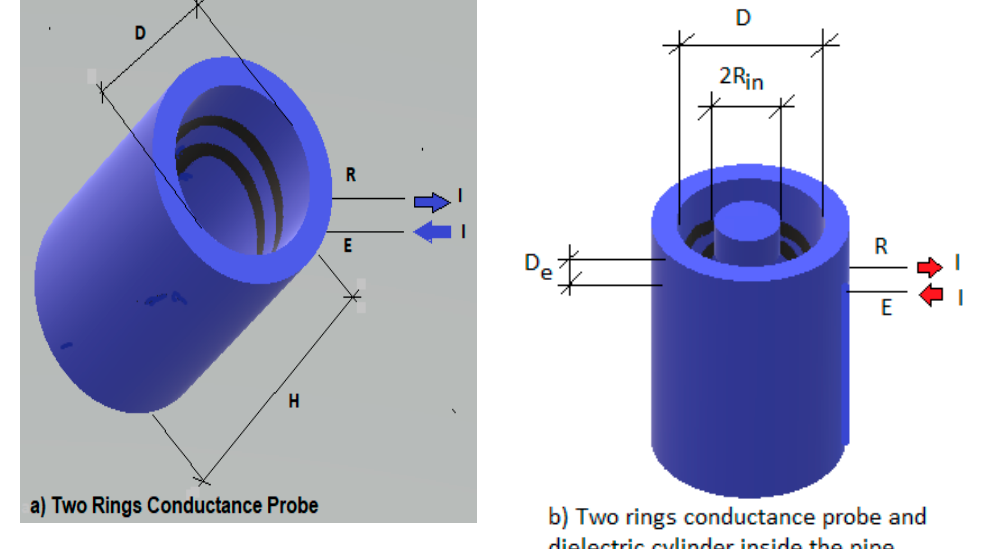
Figure 1. ( a ) Two rings conductance probe configuration with the pipe full of water; ( b ) two-ring conductance probe with an inner dielectric cylinder inside the pipe.